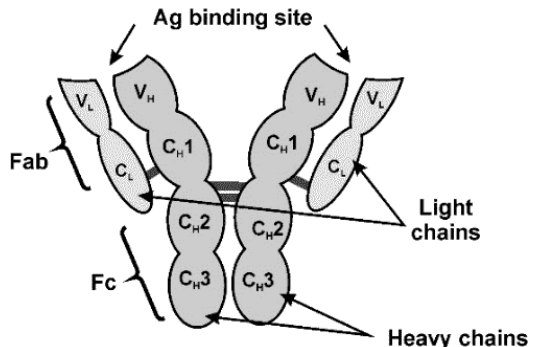
Table 1. Single-chain variable fragment (scFv) antibodies of Abs for mycotoxin determination (IC 50 – concentration corresponded to 50% change of the signal. ELISA – enzyme linked immune sorbent assay, K -affinity constant, K D -dissociation constant, LOD — limit of detection). Mycotoxin Production